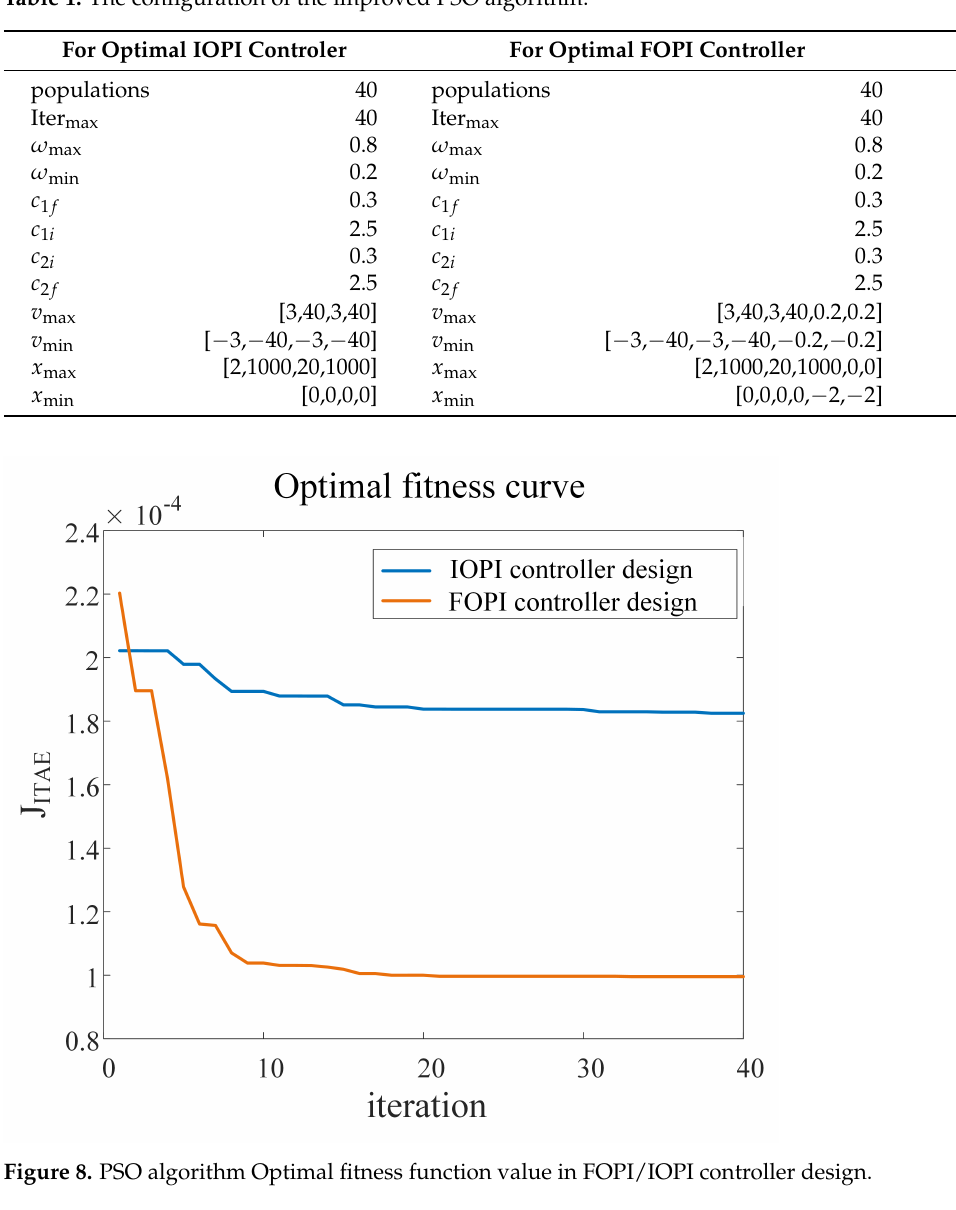
Table 1. The configuration of the improved PSO algorithm.